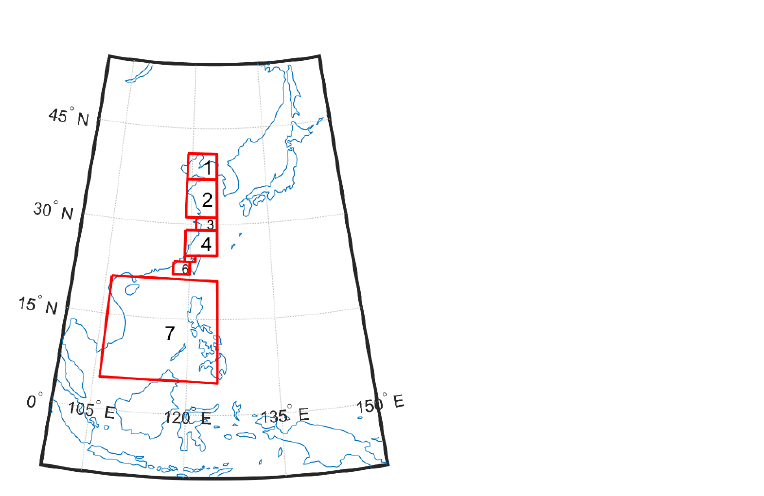
Figure 6. Location of the seven sea areas around China. Table 1. Longitude and latitude range and characteristics of study areas.